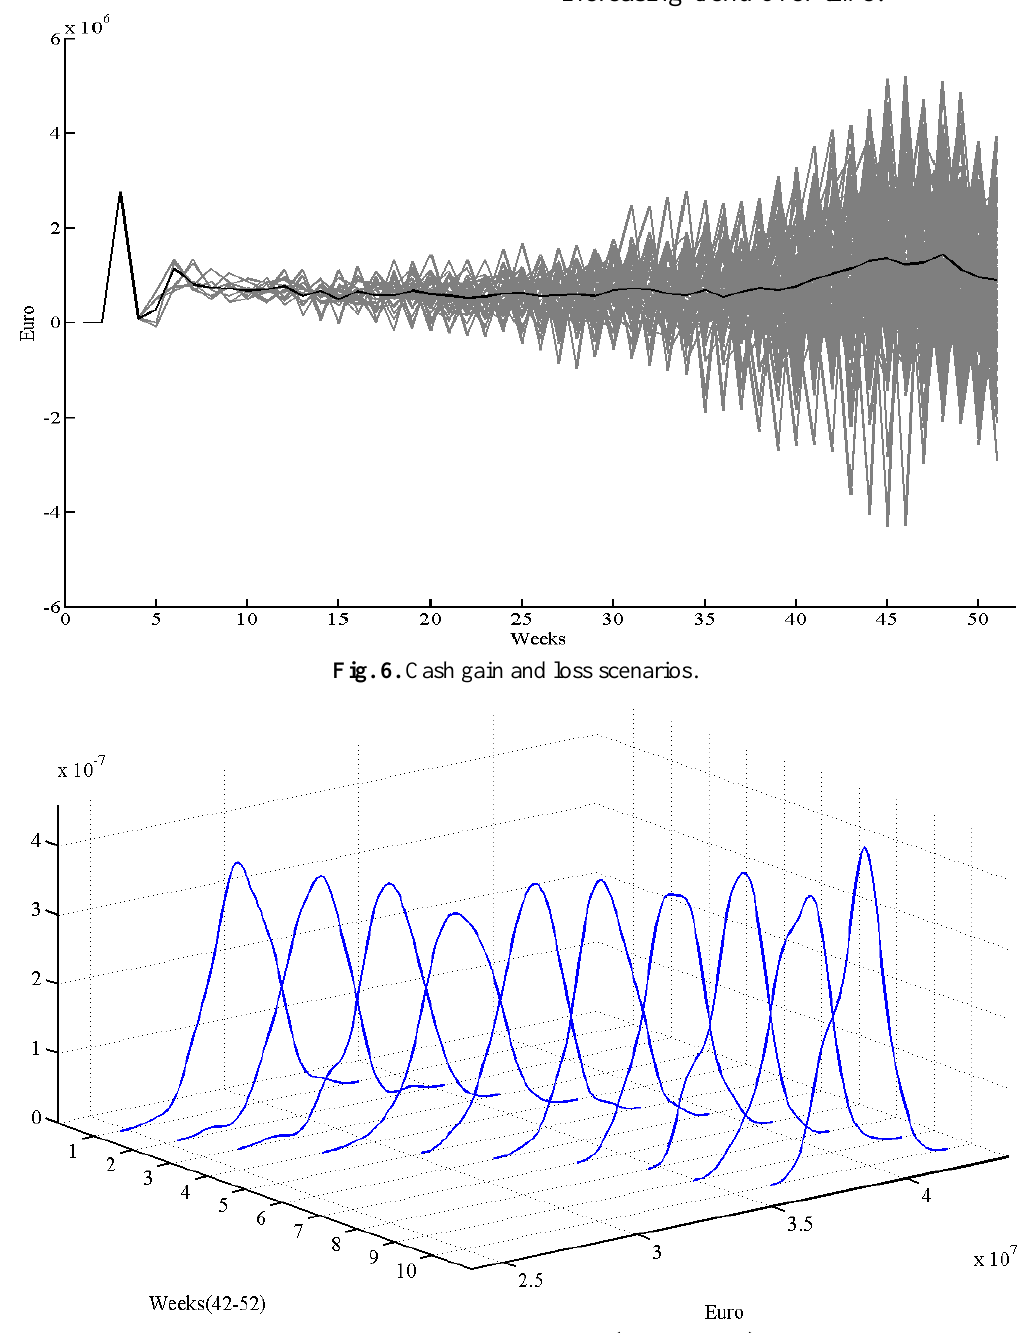
Fig. 7. Accumulated cash density (weeks